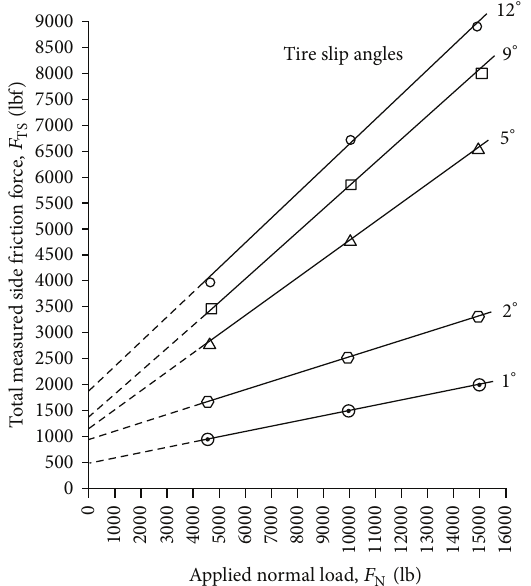
Figure 9: Yager et al. [9] side friction force results from tests of full-scale, freely rotating aircraft tires on textured concrete at five different slip angles, replotted in accordance with the tire-loading- based approach illustrating quantification of the load-dependent side friction force ( 𝐹 TS ) and values of the associated constant microhysteretic friction force, 𝐹 Hs , shown in Table 1, obtained by extrapolation to the side friction force